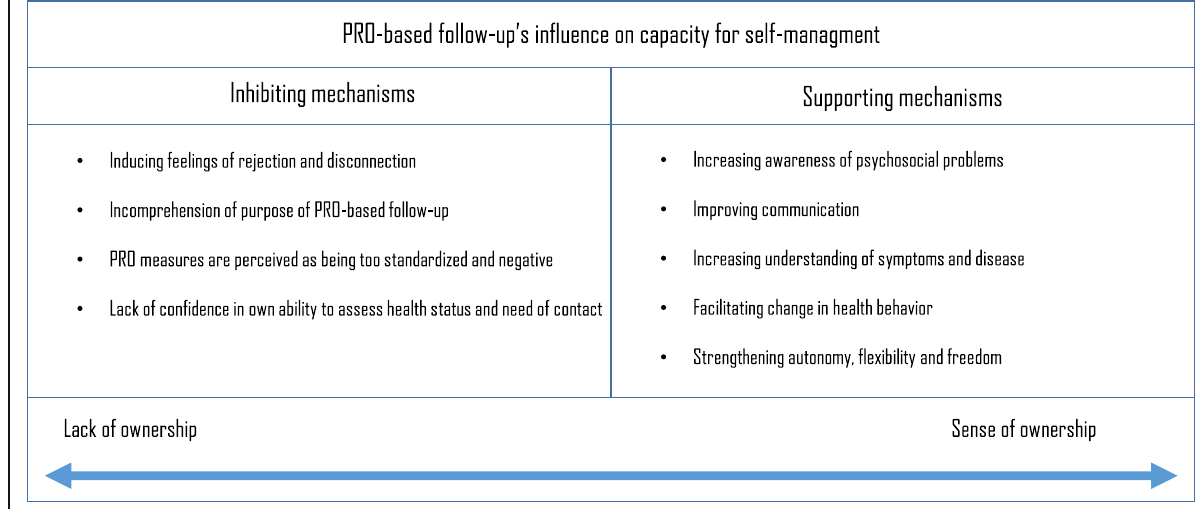
Fig. 1 PRO-based follow-up ’ s influence on capacity for self-management. The figure represents inhibiting and supporting mechanisms for patients ’ capacity for self-management. The double-arrow illustrates differences in experiences of ownership towards PRO-based follow-up on a spectrum from lack of ownership to sense of ownership as a possible explanatory